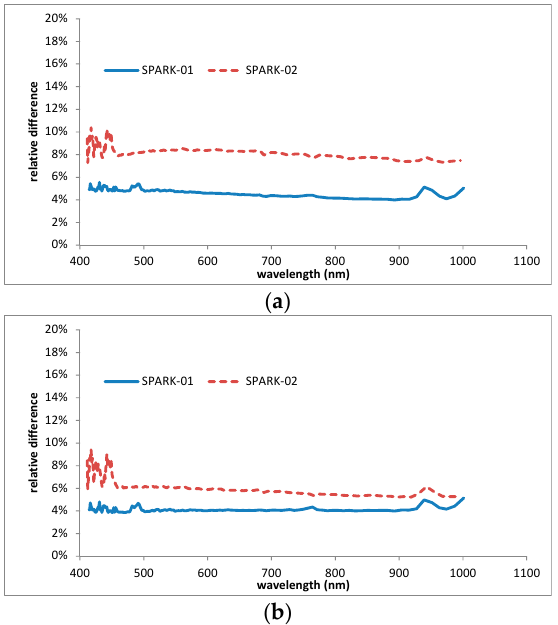
Figure 32. Total calibration uncertainty estimated for SPARK-01 and -02 using ( a ) the reflectance-based method and ( b ) the irradiance-based method. Table 7. Average relative differences for various wavelength ranges.